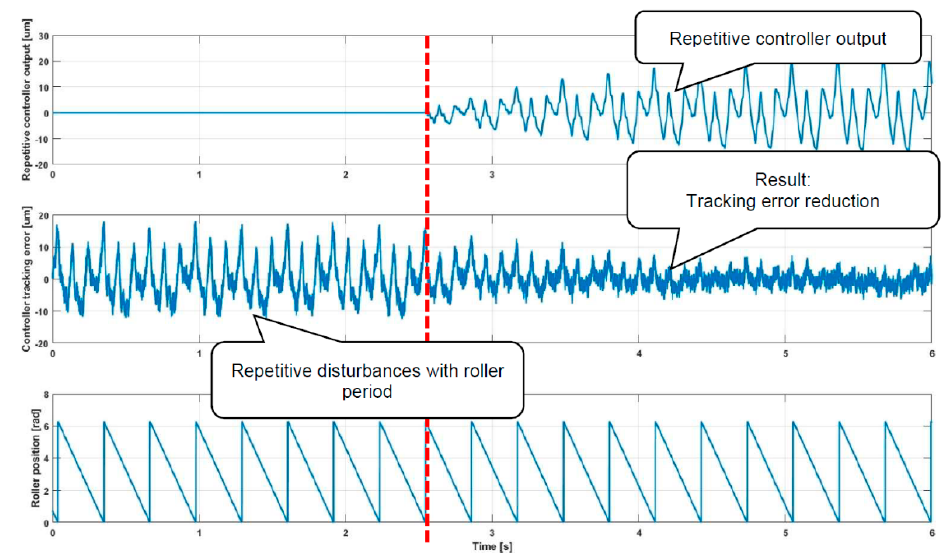
Figure 13. Pilot 1—GSC performance improvement based on repetitive control (BB9). Red line marks time when the controller was switched on. Pilot 1—GSC cumulative power spectral density (CPSD) of tracking error, 40% improvement based on repetitive control.